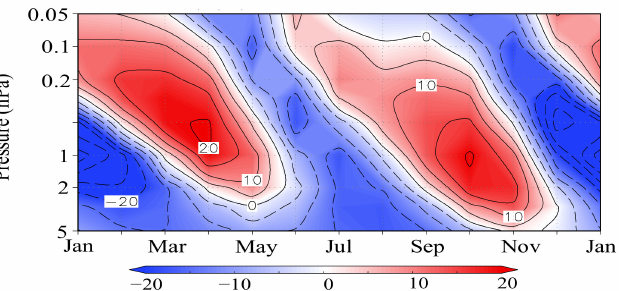
Figure 3. Time–height cross-section of the annual cycle of zonal–mean-zonal wind (ms − 1 ) averaged between 10 ◦ S and 10 ◦ N in the tropical upper stratosphere and mesosphere (5–0.05 hPa) for the control run. Contours interval is 5 ms − 1